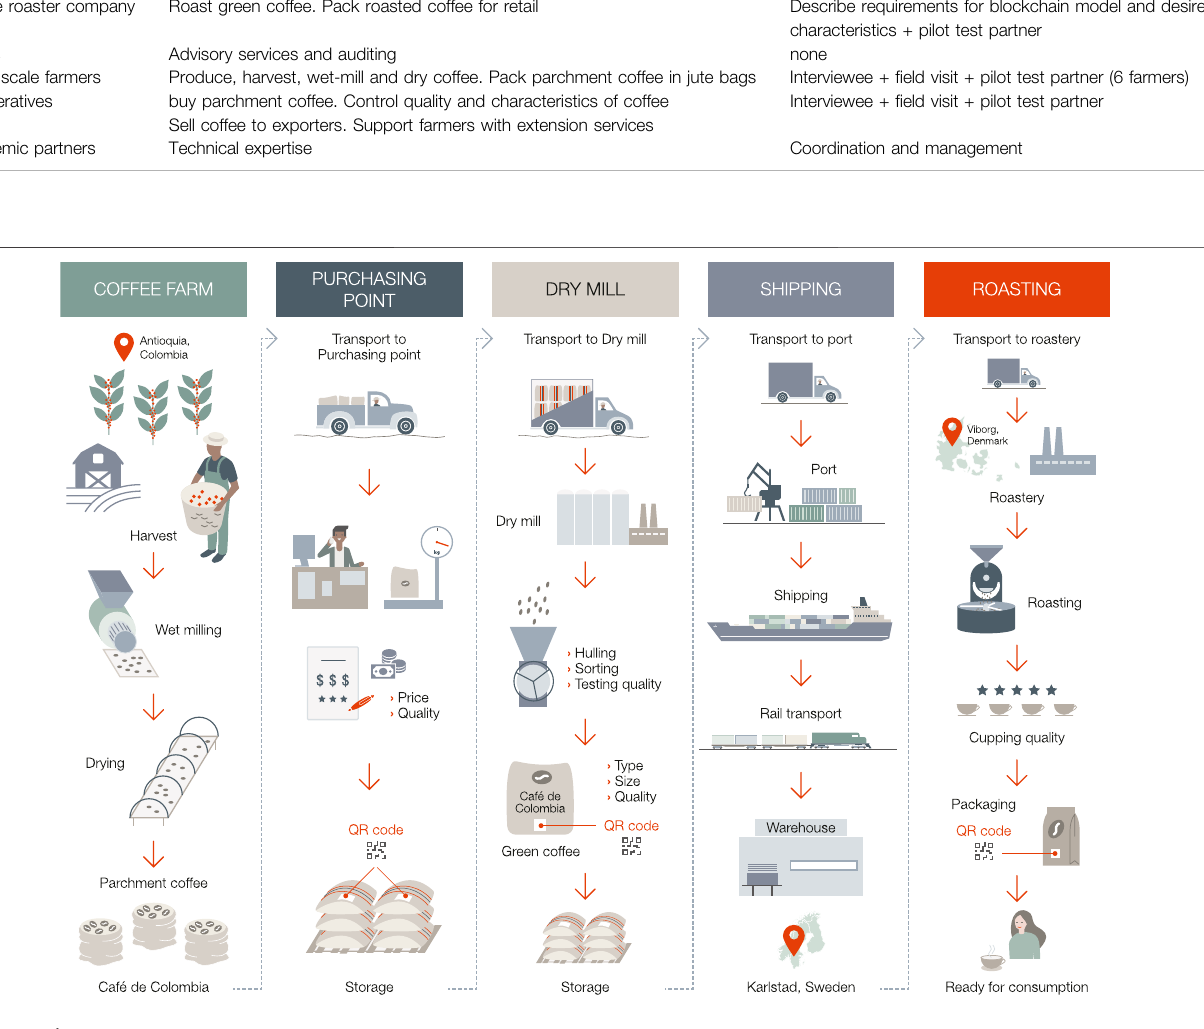
Frontiers in Blockchain |